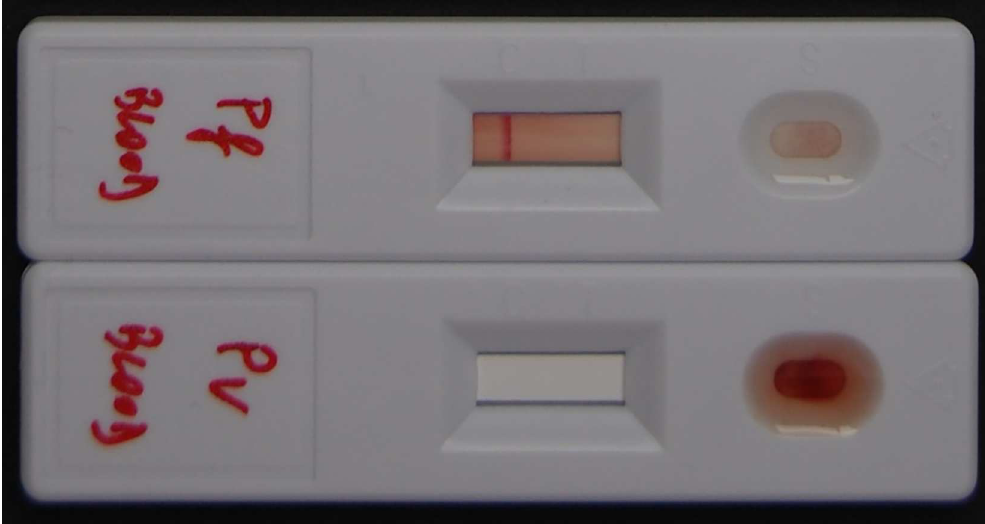
Fig 2. Above: Rapid diagnostictest with correct lateral flow and timely migrationof sample/buffer mixture. Below: Rapid diagnostictest with blocked lateral flow and no or delayed migration. The sample/buffer mixture is not flowing through the test strip but is staying behind in the sample well. This is considered as an invalid